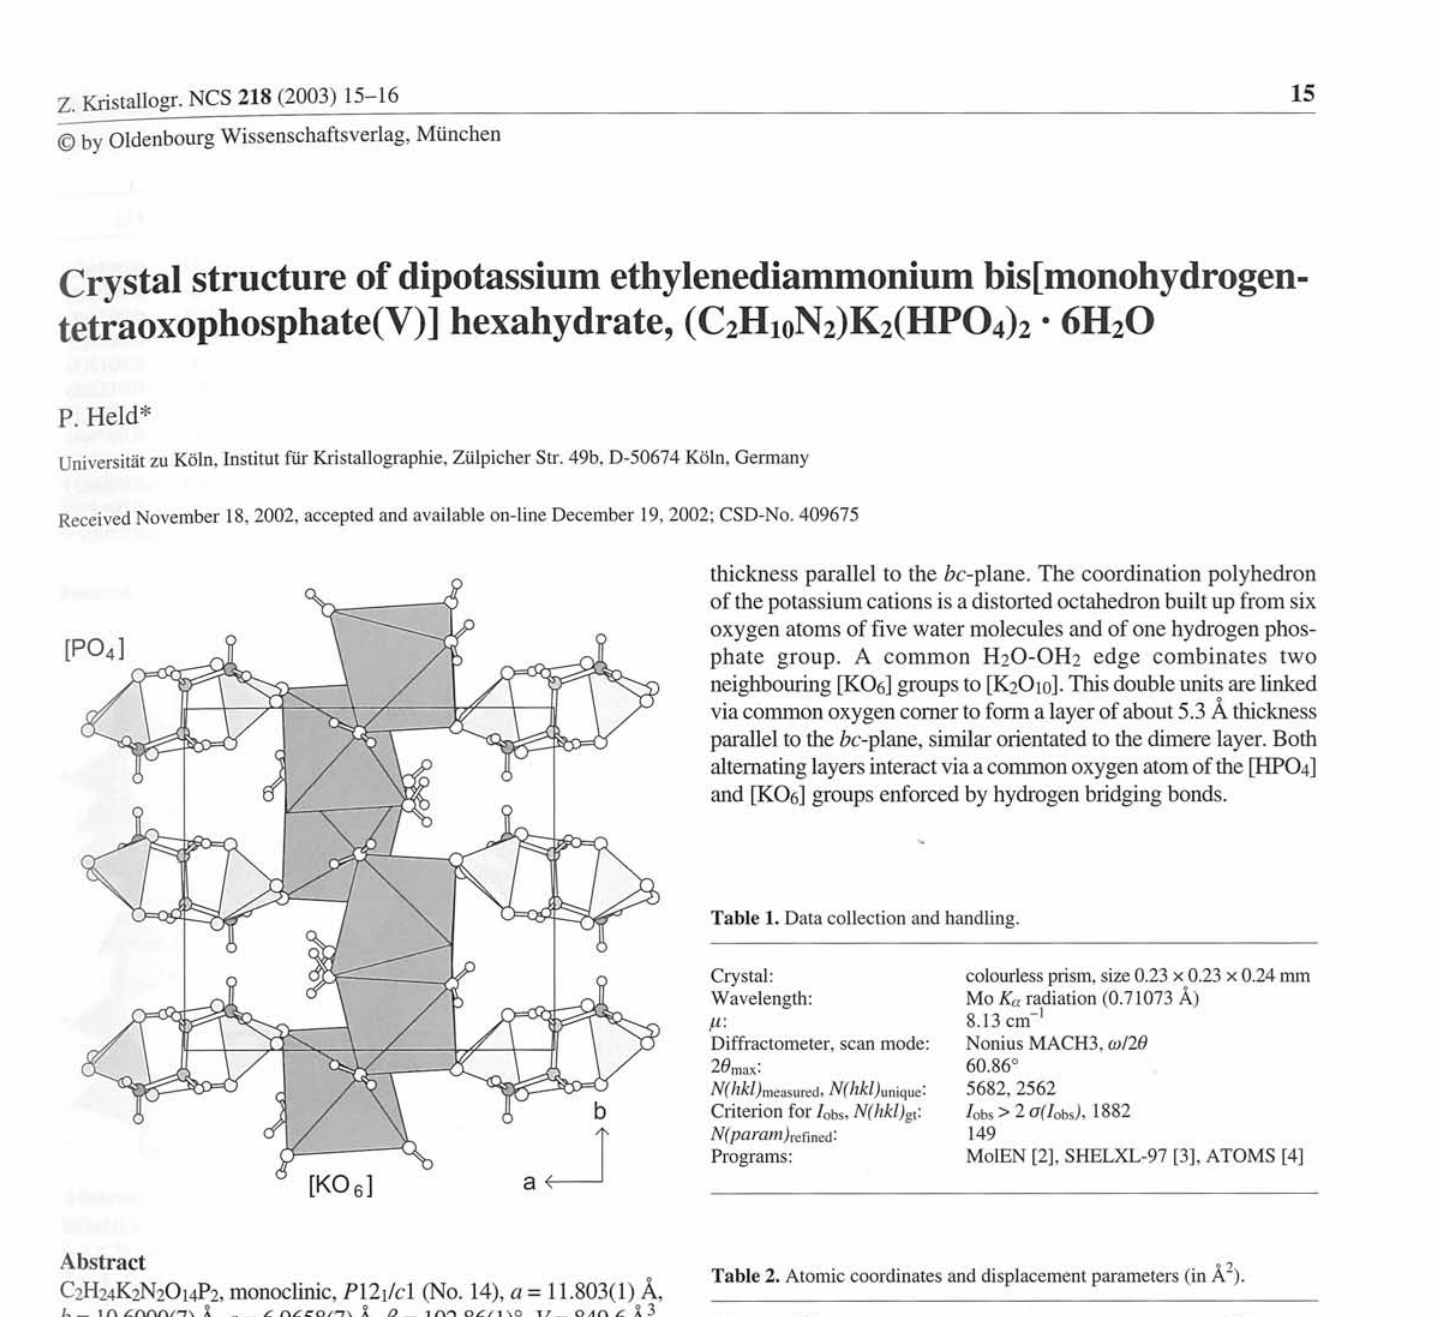
Table 2. Atomic coordinates and displacement parameters (in Á 2